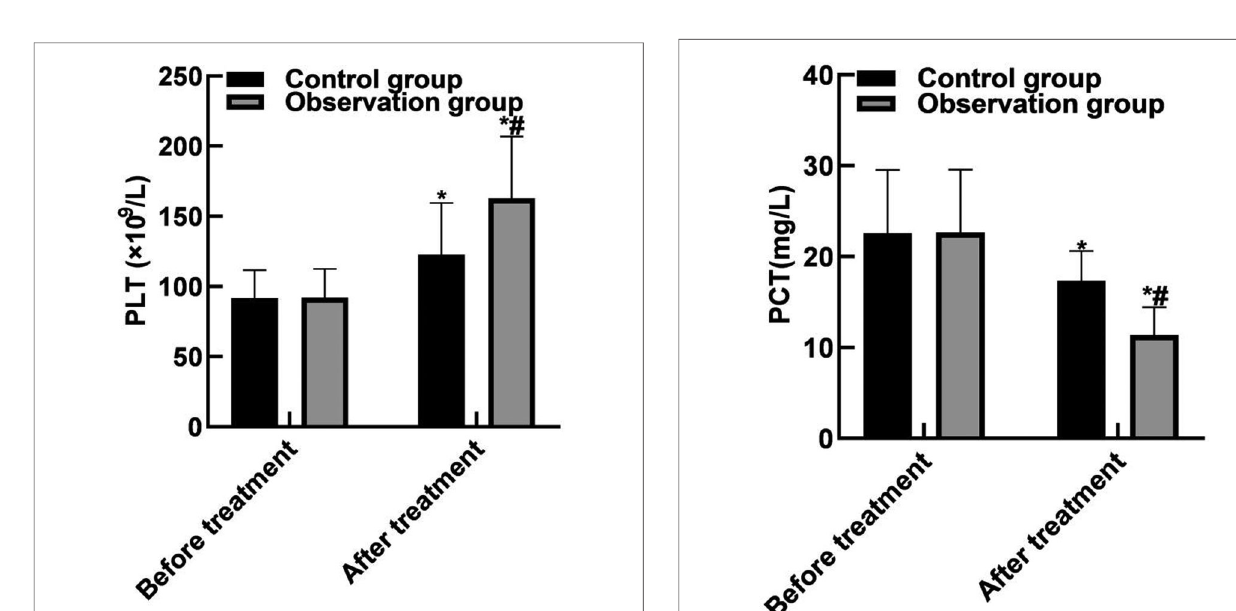
FIGURE 4 | Comparison of immune function indicators. Note: Compared with before treatment, * P <0.05; Compared with the control group, # P <0.05.